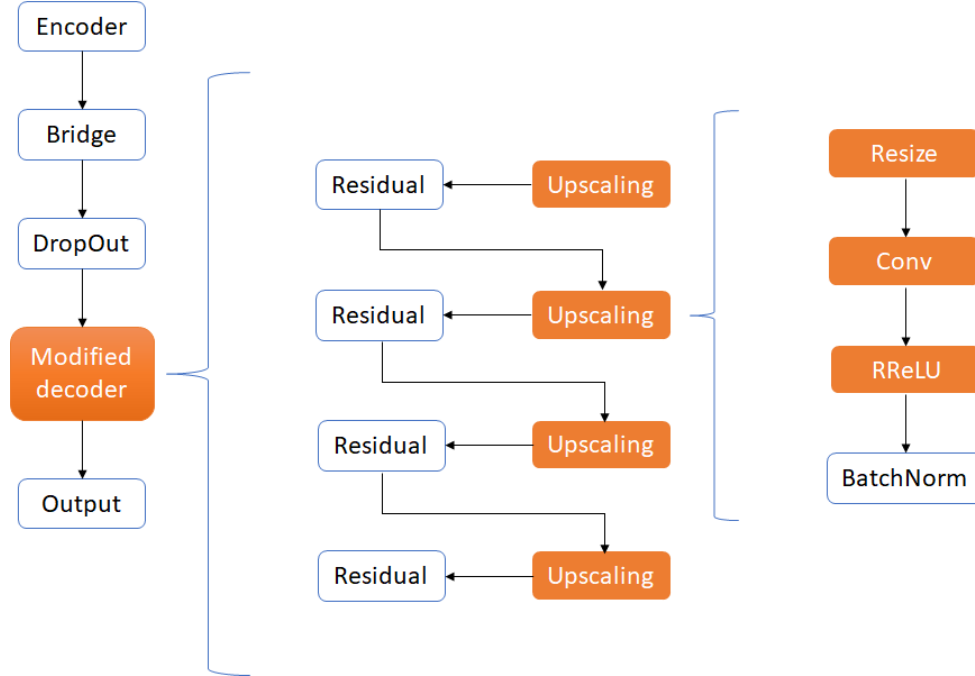
Figure 6. The proposed modified FusionNet based on the work of [89].